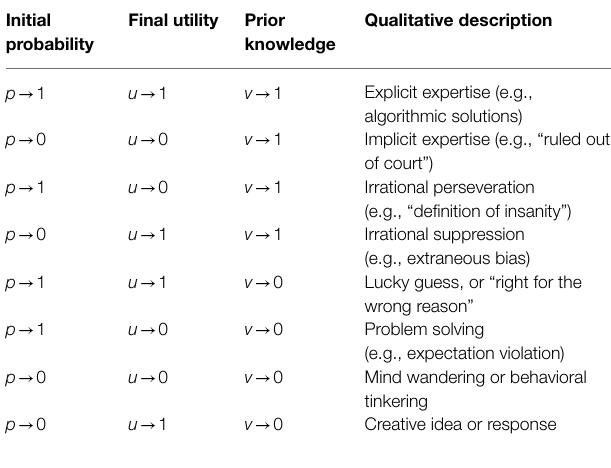
TABLE 1 | Typology based on the three combinatorial